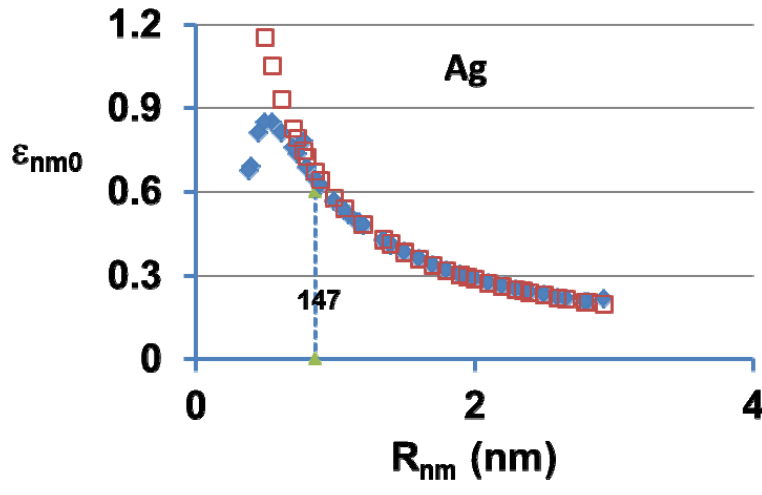
Figure 1. The energy saving coefficient ε (square points) and non-quantified (diamond points) energy saving coefficients ε are plotted versus the silver cluster radius. This coefficient is strongly weakened when R < 0.5 nm. Quantification is necessary for an atom number n <